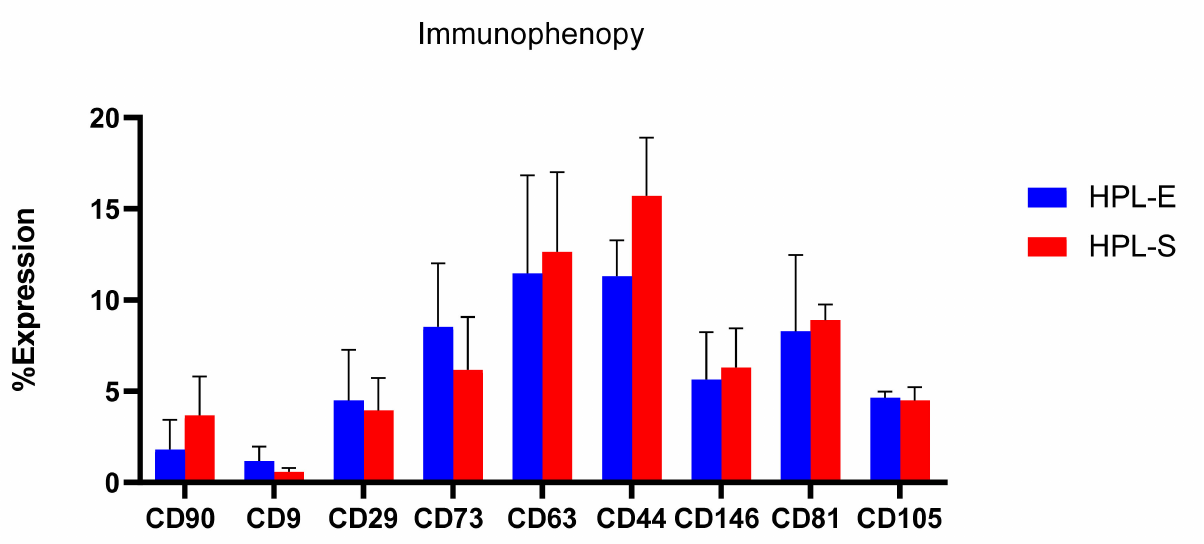
Figure 4. Flow cytometry analysis of EVs obtained from BM cell lines 1, 2, and 3 expanded in HPL-S or HPL-E. Multifactor ANOVA, mean values ± LSD, n = 3 are illustrated. No statistical differences are reported between two HPLs in all analyzed